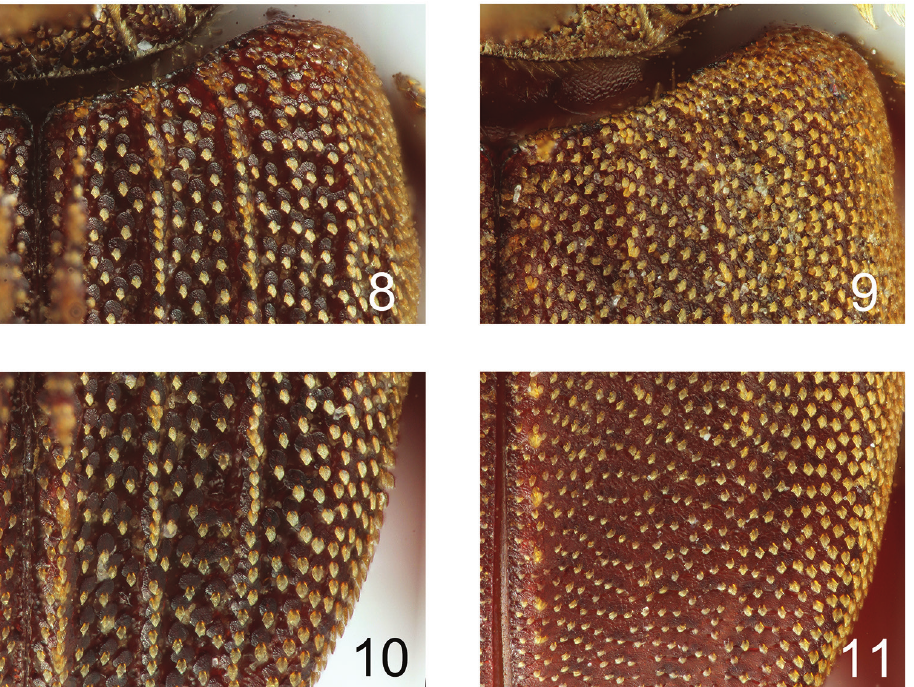
Figures 8–11. Comparison of scale between Cheleion jendeki and C. watanabei sp. n. 8, 10 C. jendeki ( ♂ ) 9, 11 C. watanabei sp. n. ( ♀ holotype) 8, 9 base of right elytron 10, 11 posterior part of right